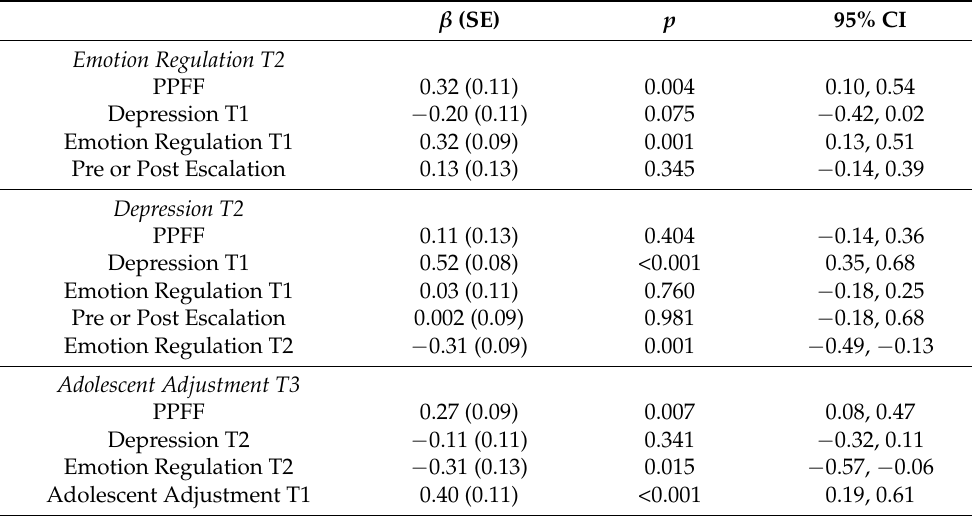
Table 4. Indirect effects model: Adolescent adjustment via maternal